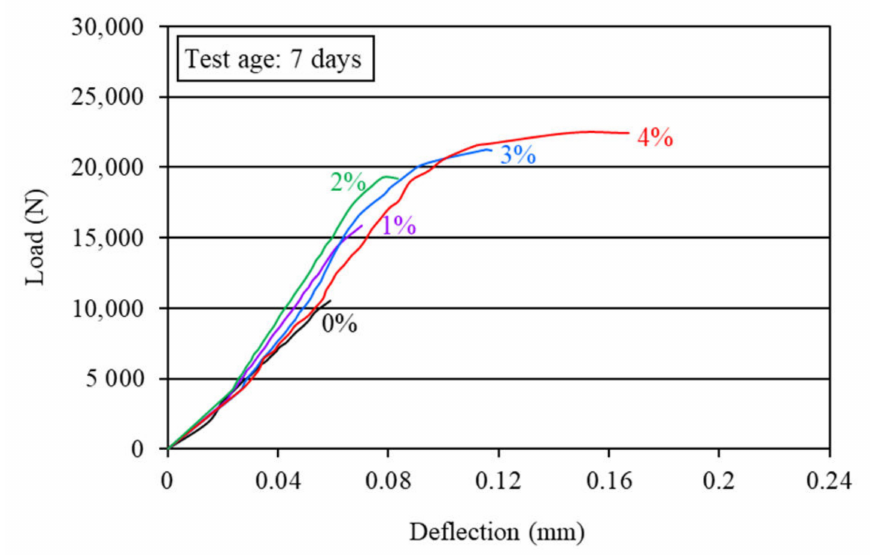
Figure 6. Characteristic flexural load-deflection behavior of the mortar composites at 7 days.